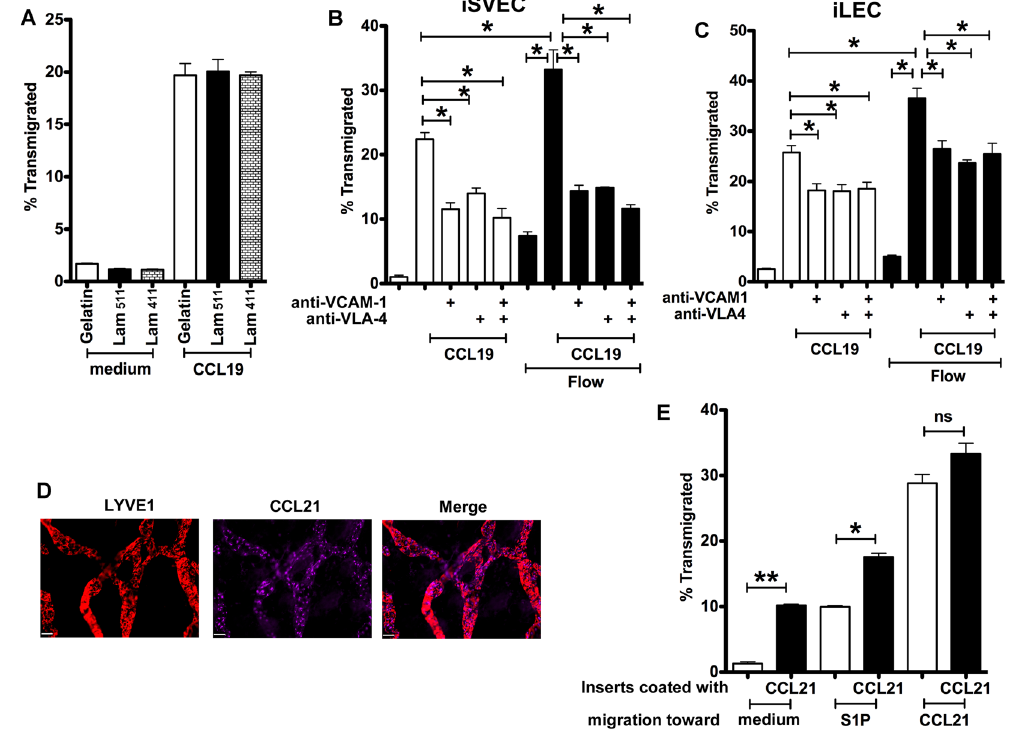
Figure 4. Stromal fibers, fluid flow, and chemokine position regulate LEC and migration. ( A ) CD4 T cell migration toward CCL19 across iSVEC4-10 with inserts coated with gelatin, laminin α 4 β 1 γ 1 and laminin α 5 β 1 γ 1. (B-C) CD4 T cell migration across iSVEC4-10 ( B ) or iLEC ( C ) toward CCL19 with or without flow, and blocked with anti-VLA-4 and anti-VCAM-1 mAb. ( D ) Ear whole mount staining of CCL21 and Lyve-1, x20, scale bar 42 μ m. ( E ) CD4 T cell migration toward S1P or CCL21 across iSVEC4-10 coated with